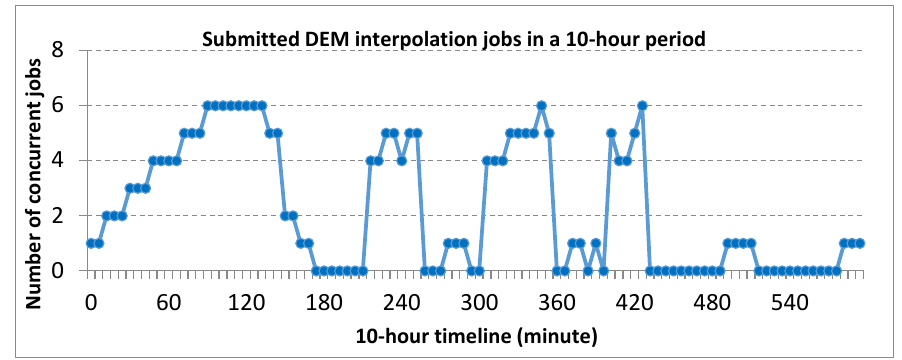
Figure 4. One hundred workloads submitted to the cluster in a 10-hour period with a time spacing of six minutes. A total of 224 jobs were submitted (each dot representing a workload).